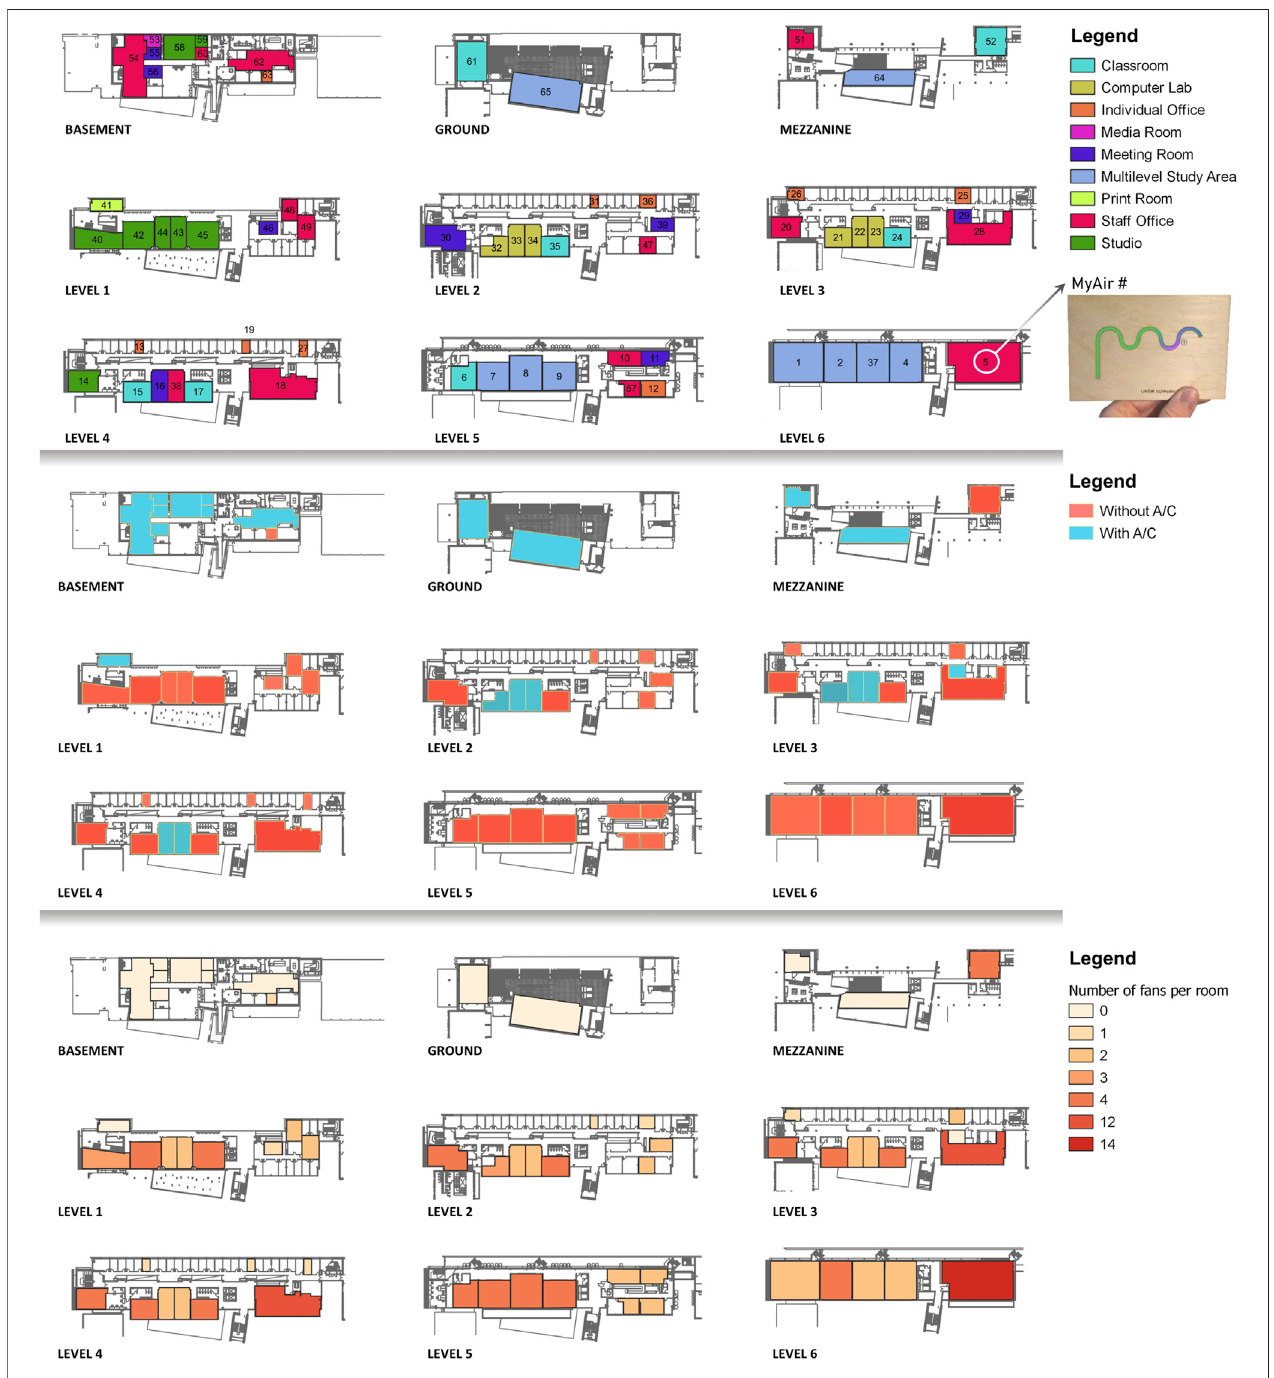
FIGURE 2 | GIS representation of monitored rooms across the different levels of the Red Centre. The three colormaps correspond to room use, presence of air conditioning systems, and fans. The numbers on the maps correspond to the MyAir identi fi cation number, as reported in Supplementary Appendix Table A1 .